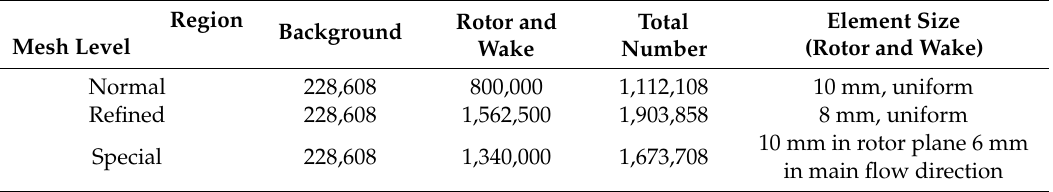
Table 1. The comparison of element number and element size between three mesh levels (Unit: number of elements).